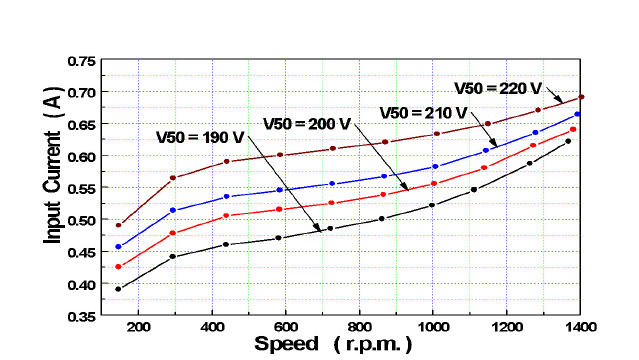
Fig. 12. Variation of input current versus motor speed (Experimental).